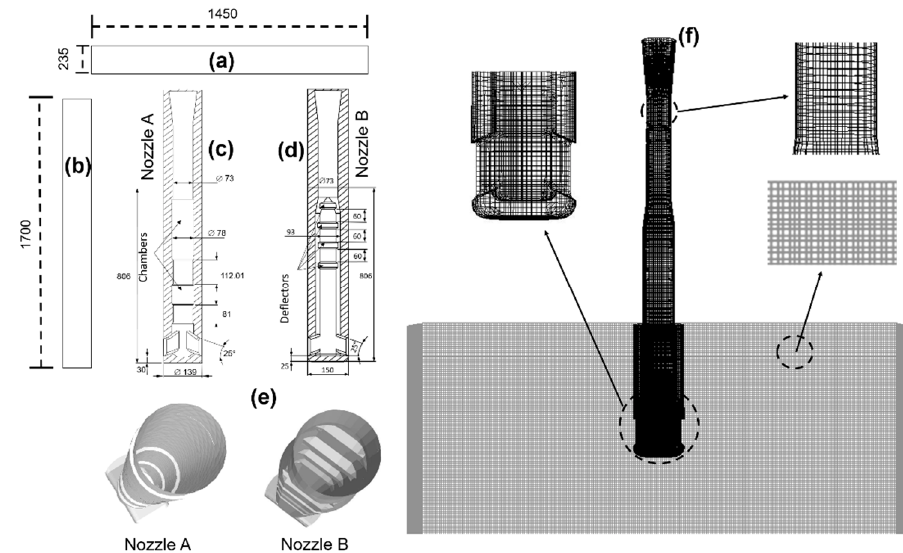
Figure 1. Geometries including dimensions of the model (mm), ( a ) upper view of the mold, ( b ) lateral view of the mold, ( c ) nozzle A dimensions, ( d ) nozzle B dimensions, ( e ) nozzle A and B on a perspective view, and ( f ) computational mesh with some close views .